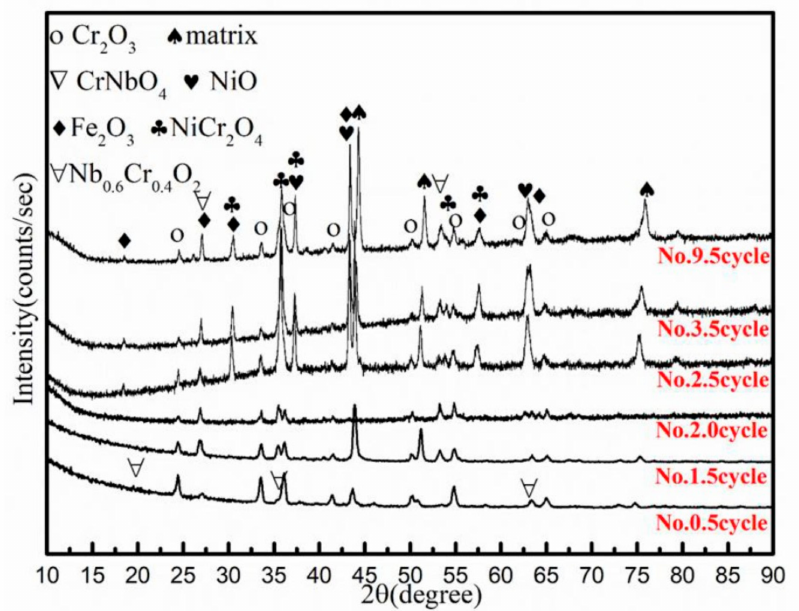
Figure 4. XRD results of the corrosion products remaining on the sample surface (No. 0.5, 1.5, 2.5, 3.5, 9.5 cycle) and spalling corrosion product powder filtered from 3.5%NaCl solution after No. 2